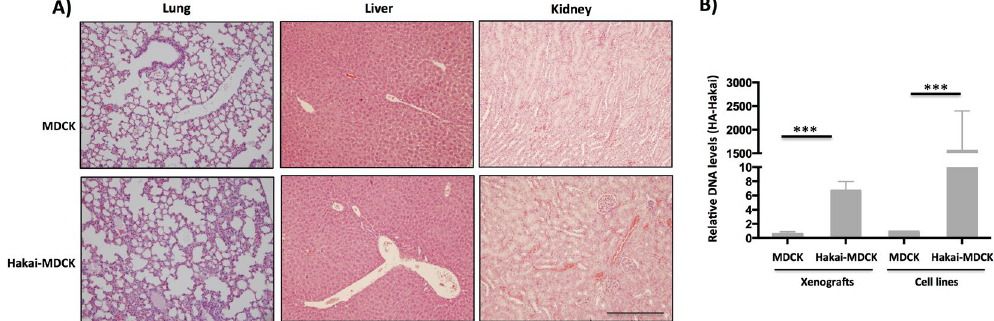
Figure 5. Hakai induces lung micrometastasis in nude mice. (A) Analysis of macrometastasis presence in lung, liver and kidney. MDCK or Hakai-MDCK cells were inoculated into the flank of nude mice and after 38 days the indicated organs were excised, fixed and stained with H&E in order to detect macrometastasis. Representative pictures were taken with a 10x objective. Scale bar, 500 μ m. (B) The presence of tumour cells into the mice lung was assessed by quantitative PCR analysis of HA-Hakai sequences as indicated in Materials and Methods. Tumour xenografts from MDCK and Hakai-MDCK injected cells ( n = 4 and n = 5 respectively) were measured and MDCK and HA-MDCK cell line were used as negative and positive controls, respectively ( *** P <